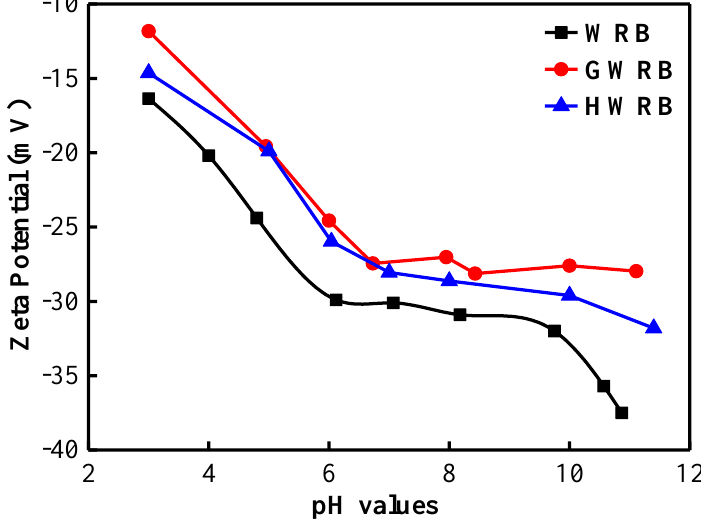
Figure 7. The zeta potential of WRB, GWRB, and HWRB.